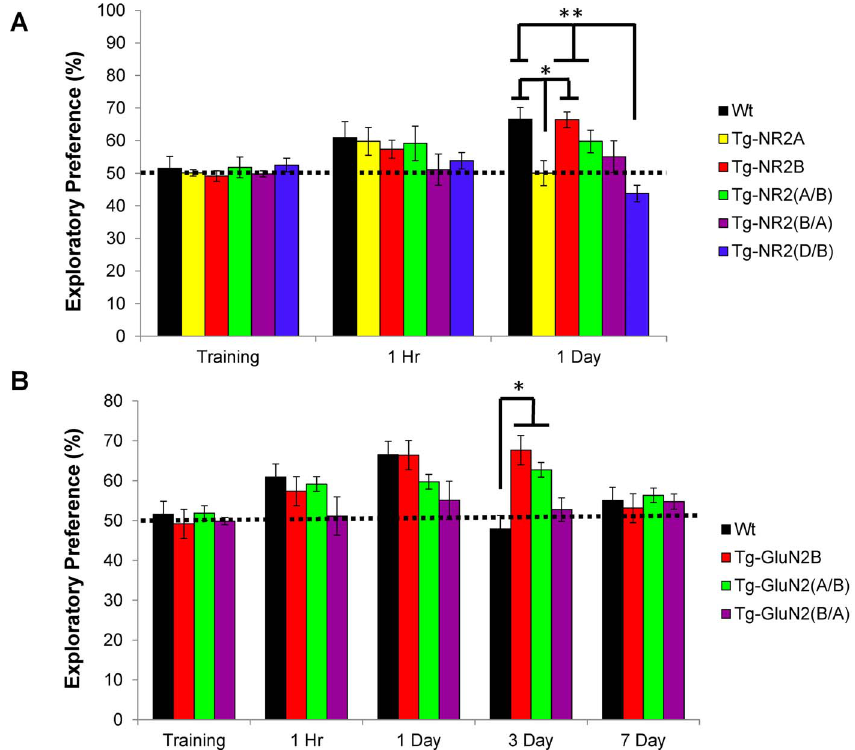
Figure 2. Enhanced long-term recognition memory of the Tg-GluN2A 2B(CT) mice and impaired long-term memory on the Tg- GluN2D 2B(CT) mice. ( A ) All groups of mice tested showed similar exploratory behavior in the training session. At the one hour retention session, the Tg-GluN2A, Tg-GluN2B and Tg-GluN2A 2B(CT) mice showed similar interest in the novel object as the wild-type mice. Whereas the Tg-GluN2B 2A(CT) and Tg-GluN2D 2B(CT) mice show almost no preference for the novel object. At the 24 hour retention test, as expected the Tg-GluN2A and Tg-GluN2D